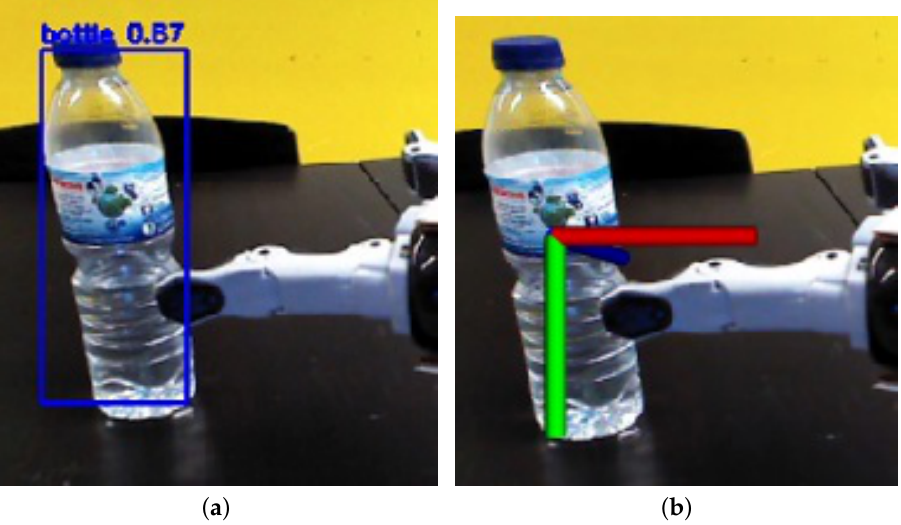
Figure 4. Target localization: ( a ) YOLO bounding box; ( b ) 3D pose obtained through depth